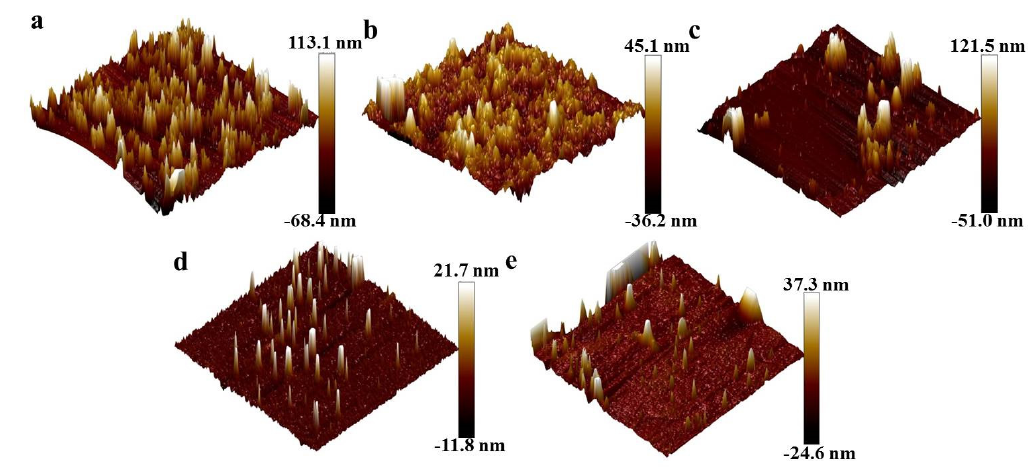
Figure 11. AFM images oil-wet calcite modified with ( a ) SiO 2 , ( b ) MgO, ( c ) ZrO 2 , ( d ) TiO 2 , and ( e ) γ -Al 2 O 3 .